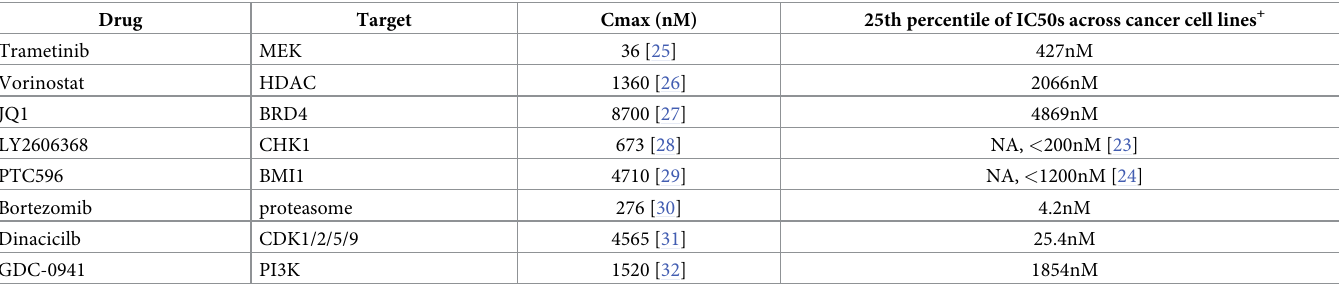
Fig 2. Sensitivity to MEK and PI3K inhibitors. (A) Dose response curves to the MEK inhibitor Trametinib and PI3K inhibitor GDC-0941 of our NF1 associated HGG cell lines. Error bars denote the standard deviation. NR denotes expression of Nuclear Red fluorescence marker (B) IC50 values and 95% confidence interval (CI) for Trametinib and GDC-0941. (C) Western blot of pERK inhibition by Trametinib (20nM) and pAKT inhibition by GDC-0941 (1 μ M) in our 17 cell line. https://doi.org/10.1371/journal.pone.0277305.g002 highlighting the sensitivity of our lines. Fig 3A and 3B show an example of the potent cell kill- ing induced by a combined treatment of GDC-0941 (1000nM) and Vorinostat (500nM) of the 5746 line. Target inhibition of all compounds was confirmed by western blot, Fig 3C. Synergy studies The 13 drug combinations that showed potent cell killing across multiple cell lines were selected for further synergy analysis. Fig 3D and 3E show the synergy plot of in the 5746 line for the GDC0941 and Vorinostat (HDAC inhibitor) combination therapy. Table 1 lists if the evaluated combinations are synergistic (Synergy Score δ > 10), additive (Synergy Score Table 2. Cmax and 25 th percentile IC50 values across cancer cell